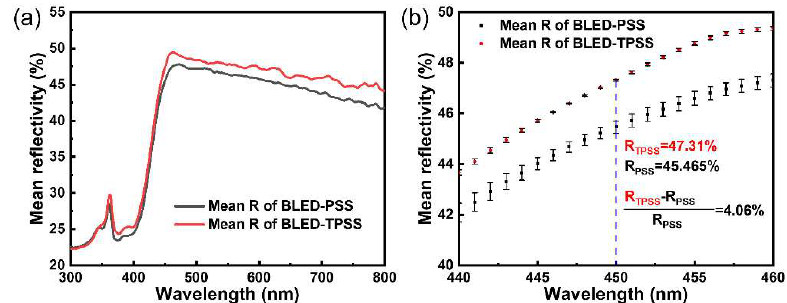
Figure 5. ( a ) Reflection spectra of BLED-PSS and BLED-TPSS wafers with incident wavelengths from 300 nm to 800 nm; ( b ) Zoomed reflection spectra at incident wavelengths around 450 nm.